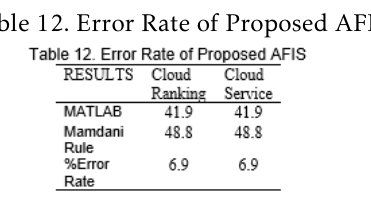
Table 12. Error Rate of Proposed